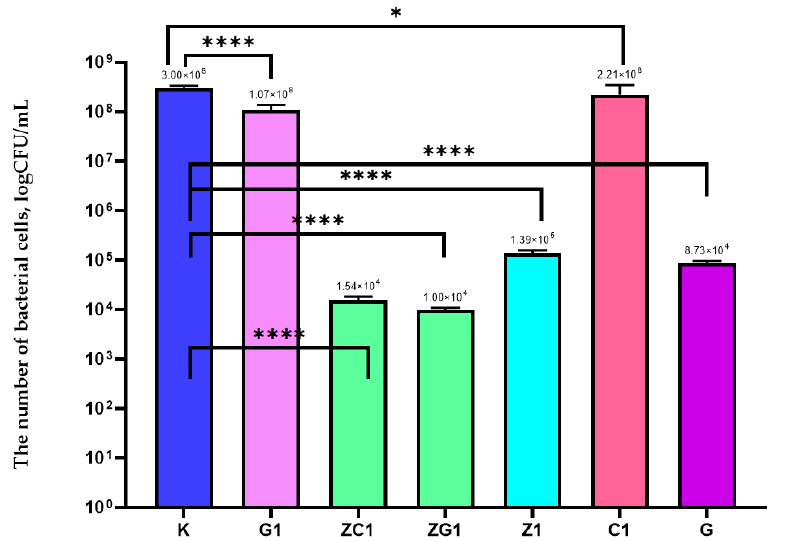
Figure 2. The influence of coatings on E . coli growth. K—PE film; G1–PE film covered with the MHPC coating containing 0.0125 g of geraniol in 100 mL carrier; C1–PE film covered with the MHPC coating containing 0.0125 g of carvacrol in 100 mL carrier; G–PE film covered with the MHPC coating containing 5 g of geraniol in 100 mL carrier; Z1–PE film covered with the MHPC coating containing 0.041 g ZnO nanoparticles in 100 mL carrier; ZG1–PE film covered with the MHPC coating containing 0.041 g ZnO nanoparticles and 0.0125 g of geraniol in 100 mL carrier; ZC1–PE film covered with the MHPC coating containing 0.041g ZnO nanoparticles and 0.0125 g of carvacrol in 100 mL carrier, one-way ANOVA: ns—not significant; *— p < 0.05; **— p < 0.01; ***— p < 0.001; ****— p < − 0.0001.